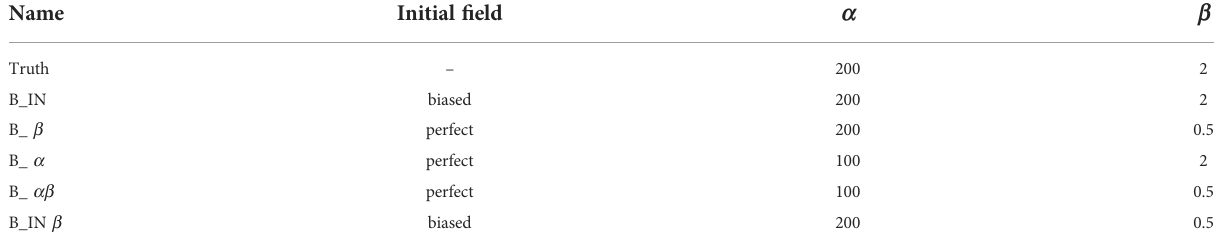
TABLE 1 Design of identical twin experiment, where “ Truth ” indicate the truth experiment, and “ B_IN ” , “ B_ b “ , “ B_ a “ “ B_ ab “ , and “ B_IN b “ indicate the bias coming from initial fi eld, b , a , both a and b , and initial fi eld together with b , respectively.